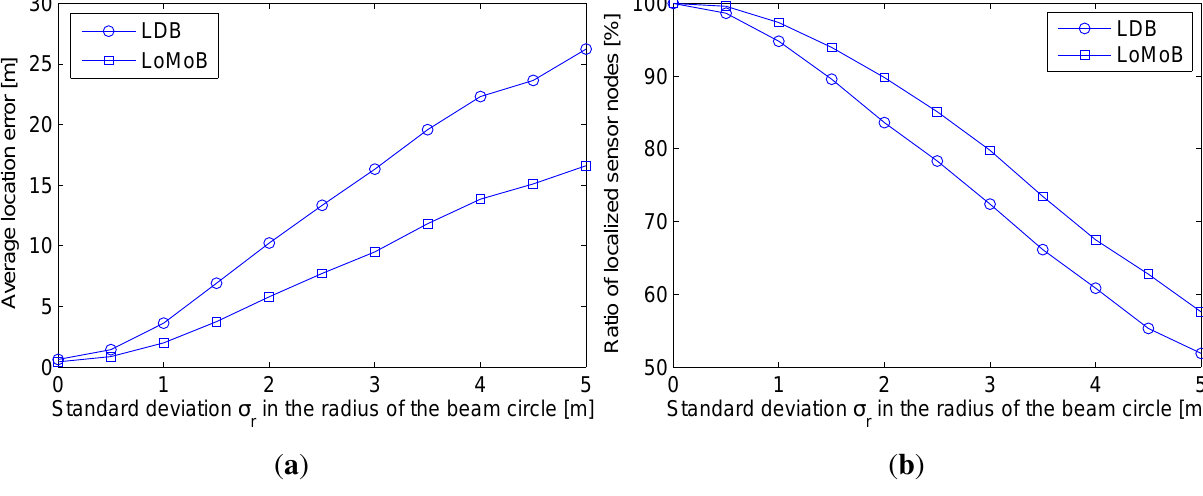
in the radius of the r